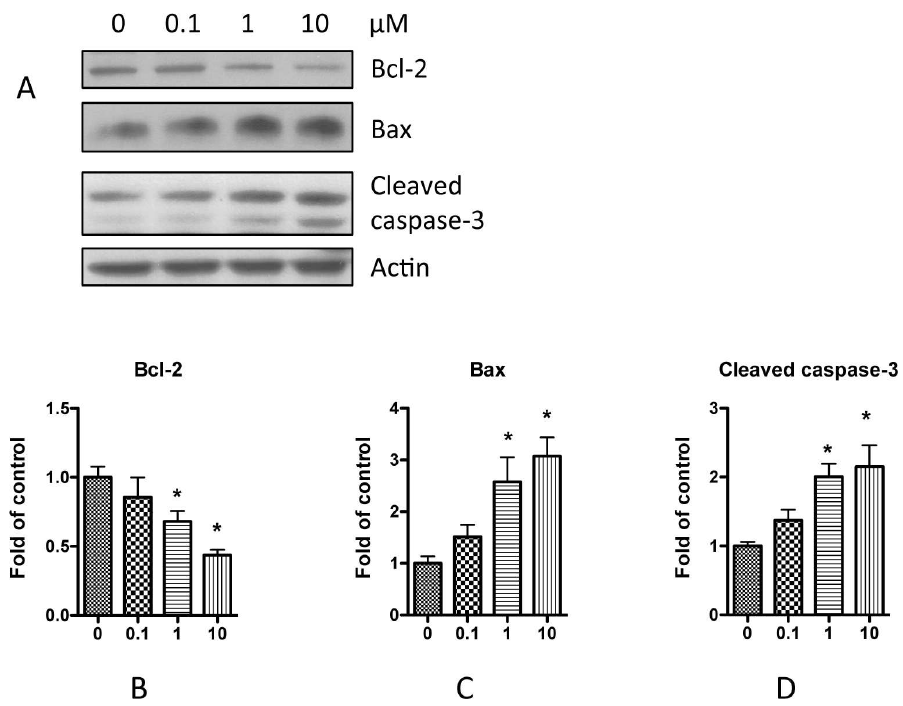
Fig 4. Nicotine treatment affects apoptosis related proteins in podocyte. Differentiated human podocyteswere treated with nicotine(0.1–10 μ M) for 24 h. Cell lysates were then collect and were subjected for Western blotting. A. Representative results were selectedto show the Western blottings. B-D. Quantification of the expressionof Bcl-2 ( B ), Bax ( C ), and Cleavedcaspase-3( D ) in A, and the results (mean ± SD) represent three independentsamples. * p < 0.05 comparedwith control (0 μ